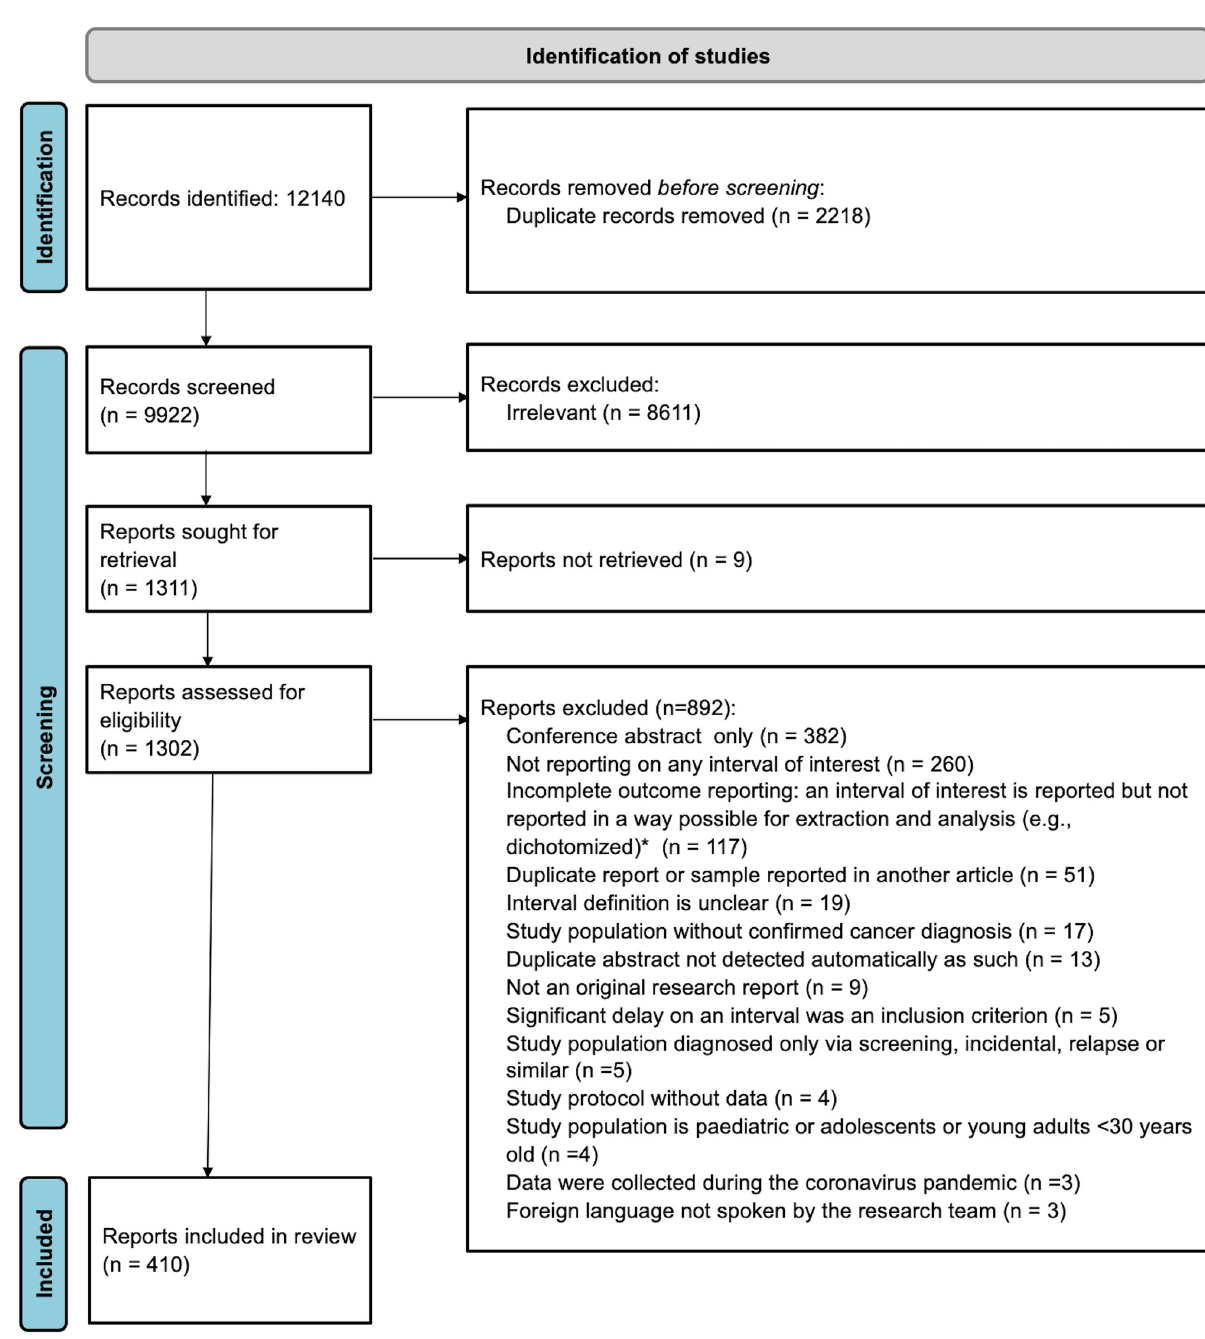
Fig 1. PRISMA flow chart of the study selection process. � Missing information was not requested from authors.